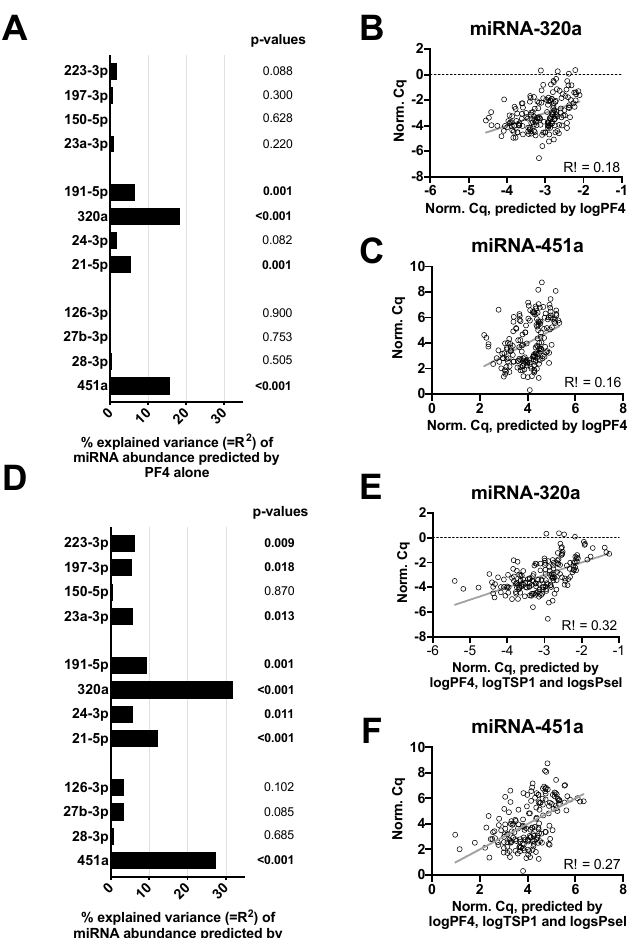
Figure 2. Dependence of miRNA abundance on platelet activation markers. To assess whether and to which extent the measured miRNA abundance might be a ff ected by in vitro platelet activation, the variance of the miRNA values that could be explained by platelet activation, i.e., the R 2 value, was determined. A theoretical value of 0% of explained variance (R 2 = 0) would indicate that the respective miRNA is completely independent of platelet activation, whereas a value of 100% would indicate that the respective miRNA could entirely be explained by platelet activation in terms of a perfect correlation. Thus, miRNAs with higher percentages are more likely to be a ff ected by in vitro platelet activation when quantified in plasma samples. ( A ) Variance percentage ( = R 2 ) of each miRNA that can be explained by PF4 alone. p -values refer to the hypothesis that PF4 alone explains miRNA variance. ( B ) Predicted vs. measured miR-320a ∆ Cq values with corresponding R 2 and r values. ( C ) Corresponding scatterplot of miR-451a. ( D ) Variance percentage ( = R 2 ) of each miRNA that can be explained by PF4, TSP-1, and sCD62P simultaneously. p -values refer to the hypothesis that PF4, TSP-1, and sCD62P simultaneously explain the miRNA variance. ( E , F ) Scatter plots showing predicted vs. measured values for miR-320a and miR-451a quantitative cycle ( ∆ Cq).